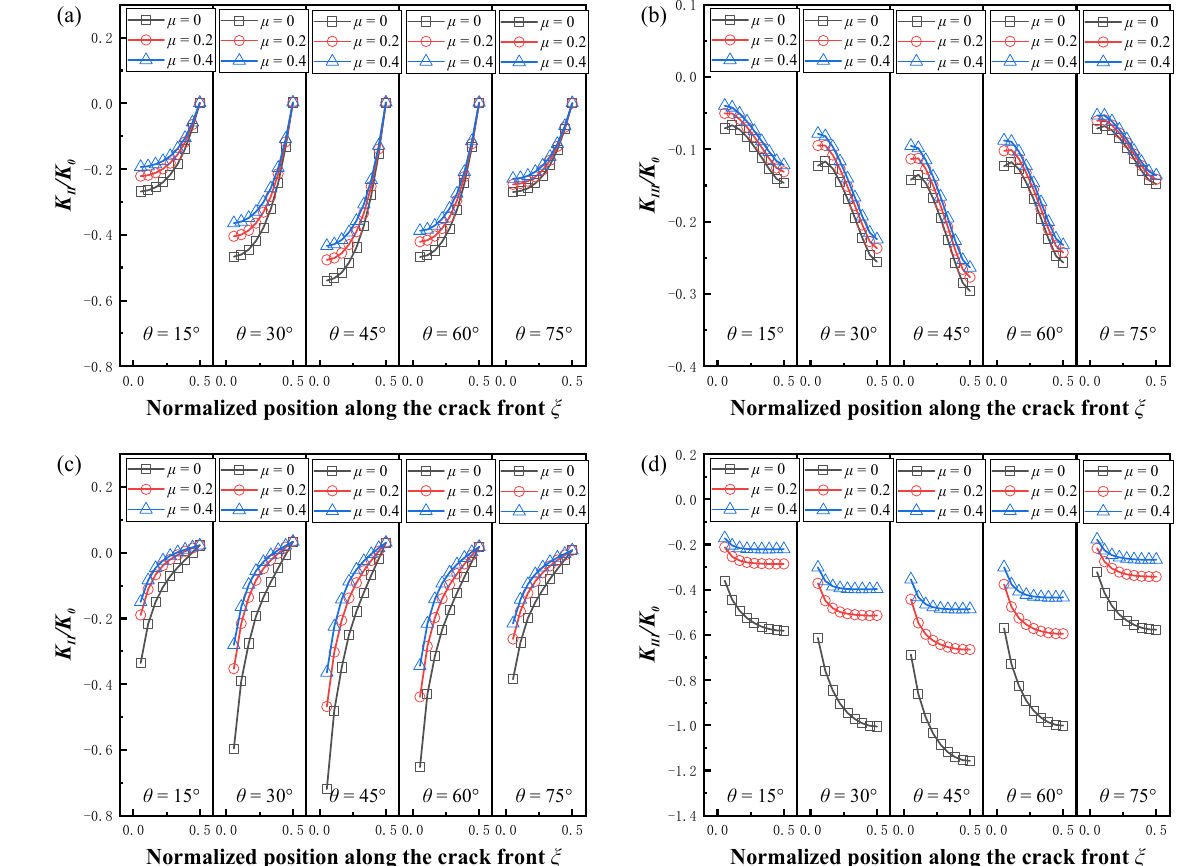
Figure 11. Effect of the coefficient of friction on normalized SIFs. ( a ) Normalized K II ( a/t = 0.2, a/c = 1.6); ( b ) normalized K III ( a/t = 0.2, a/c = 1.6); ( c ) normalized K II ( a/t = 0.6, a/c = 0.4); ( d ) normalized K III ( a/t = 0.6, a/c = 0.4).